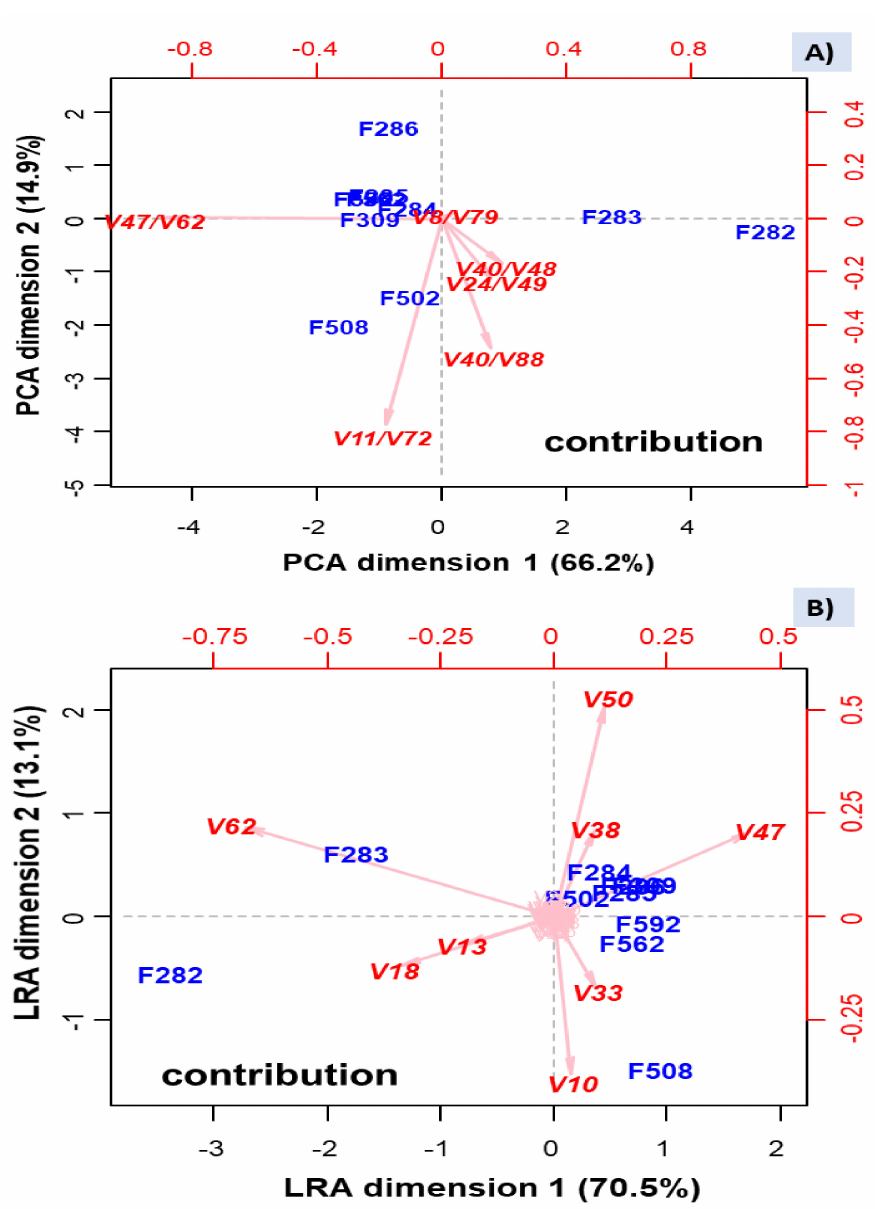
Figure 8. PCA ( A ), based on the log-ratios selected using the function STEP from easyCODA, and log-ratio analysis (LRA) ( B ), based the complete set of log-ratios. Symbols of samples correspond to industry A (F282 and F283, affected by butyric spoilage; F284, F285, F286, F309, normal fermentation) and industry B (F508 and F562, sulfidic and putrid spoilage, respectively; F502 and F592, normal fermentations). See Table S1 for the meaning of VOCs’